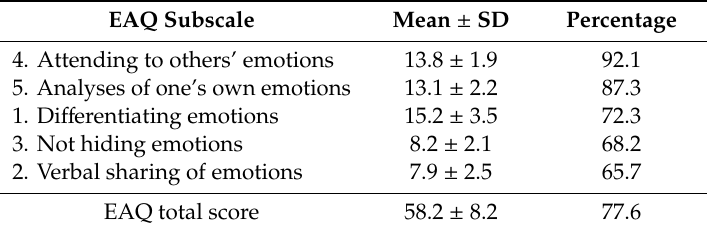
Table 2. Emotion Awareness Questionnaire (EAQ) and its 5 subscales: means, standard deviations, and percentages listed in descending